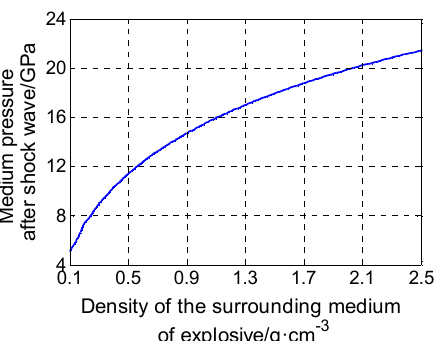
Figure 6. Effect of surrounding medium’s density on the pressure upon the medium behind the shock wavefront.